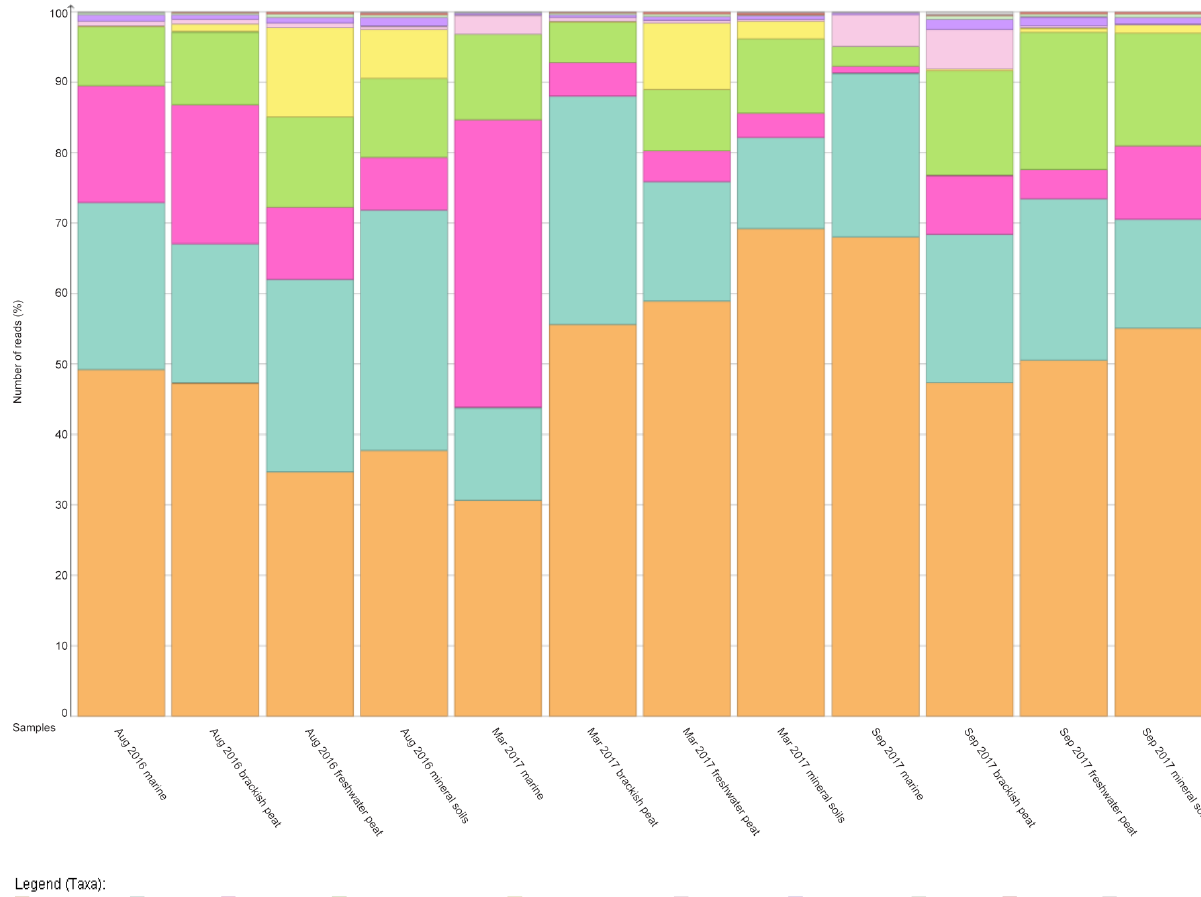
Figure 3. Relative abundance (%) of dominant bacterial (at phylum level, top 10) along the various source types (marine, brackish peat, freshwater peat, mineral soils) across three